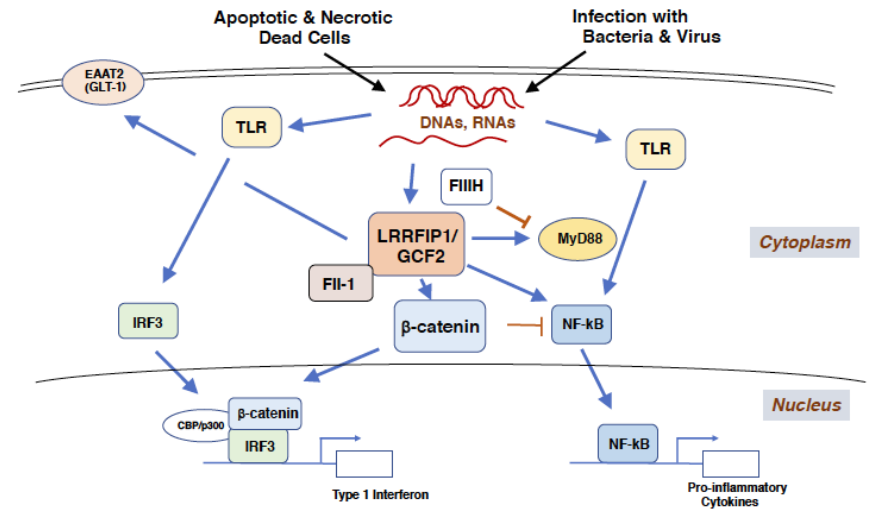
Figure 3. LRRFIP1/GCF2 binds to exogenous and endogenous nucleic acids and activates